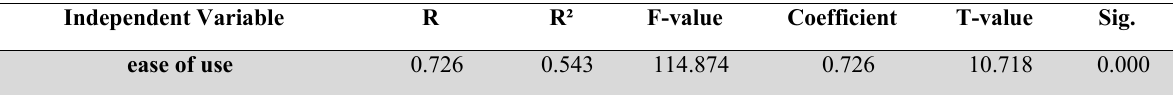
Results of SLR test of ease of use on JRCCPE